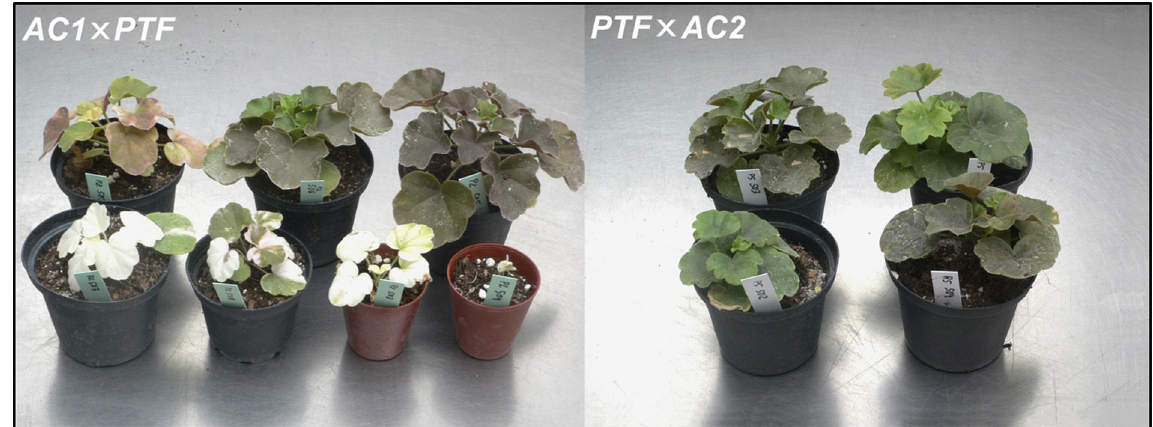
Fig. 3: Progeny from the combinations AC1 × PTF (left) and PTF × AC2 (right), 14 weeks after sowing. Pot diameters: 9 cm, 7 cm, 4 cm ( AC1 × PTF ), and 9 cm ( PTF × AC2